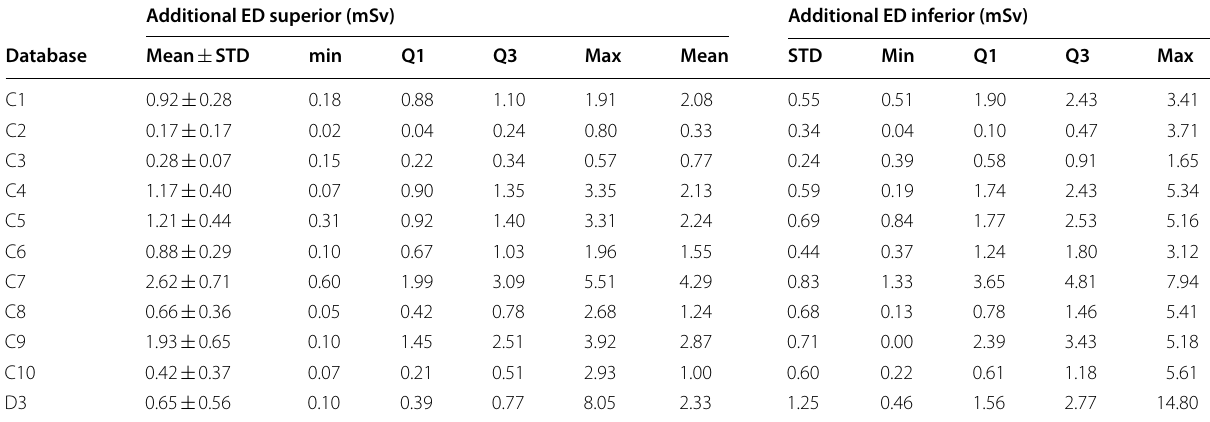
Table 2 The additional effective dose delivered to patients due to overscanning in superior and inferior directions in the different centers